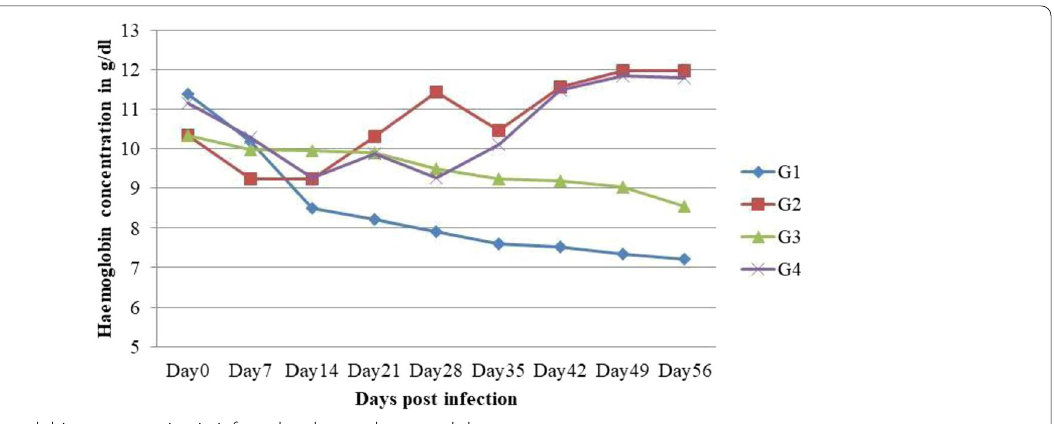
groups (Fig. 5). Significant fall from the initial values was tively. Similarly, when infected (G1) and non-infected (G2) goats were compared, TSP was much lower in G1 than in G2 ( P < 0.05). Comparison of TSP between infected sheep and goats also revealed TSP was significantly lower in G1 than in G3 (P < 0.05) on day 28 PI. Because there were notable variation between groups at day0 (before infec- tion), albumin concentration in g/dl was transformed into percentage changes in concentration with values at day0 taken as 100%.